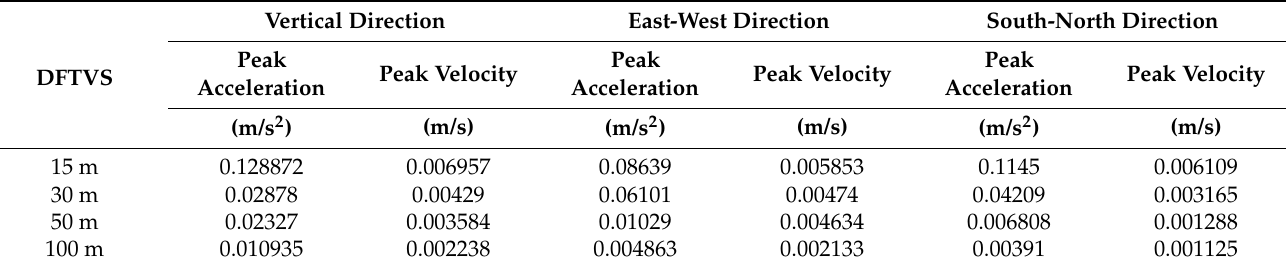
Table 3. Peak vibration values of monitoring points.